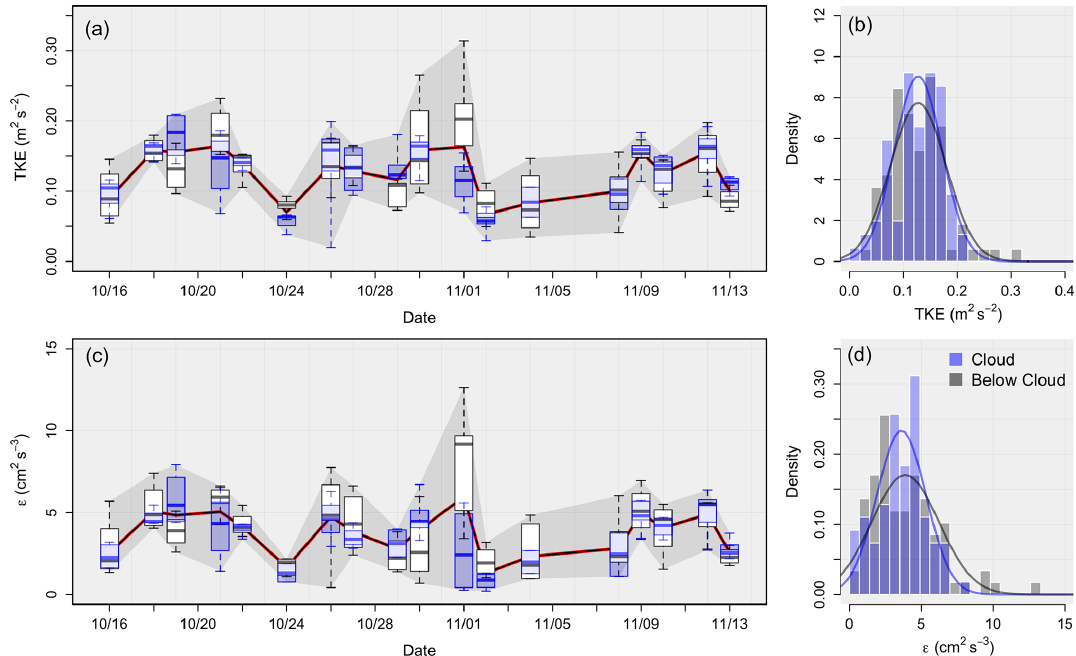
Figure 9. As in Fig. 8, except for TKE (m 2 s − 2 ) in (a) and (b) as well as (cid:15) (cm − 2 s − 3 ) in (c) and (d)